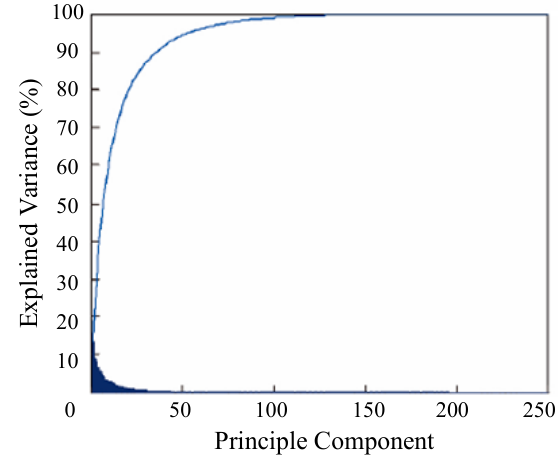
Figure 3. Principal component analysis of features from Conv3-4 on MotorRolling.